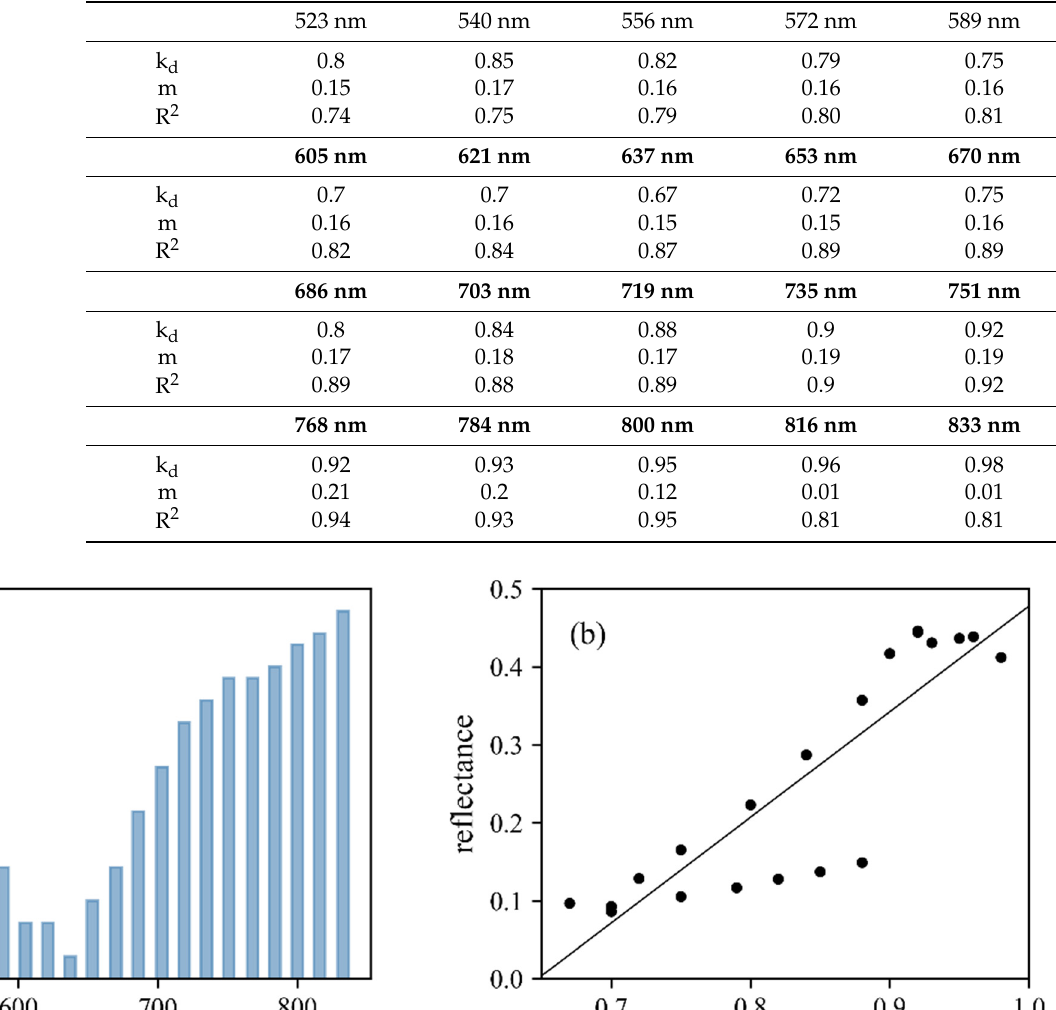
Table 3. The simulation of HSL backscattered intensity based on the linear combination of Lambertian model and Beckmann law. k d stands for the diffuse fraction, and m stands for surface roughness.